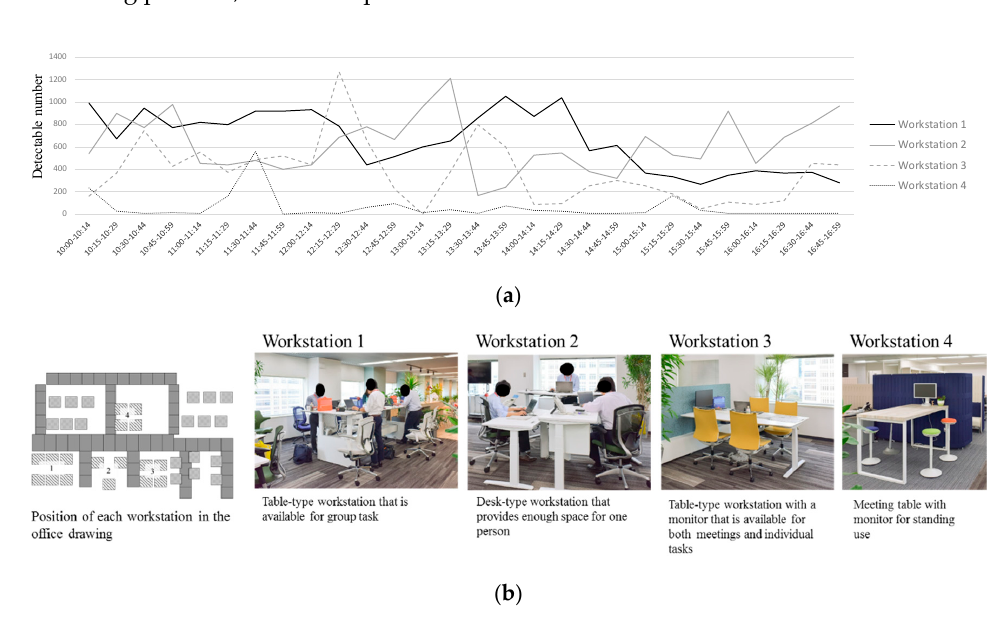
Figure 3. Detectable number of persons in each shared workstation at post-renovation. ( a ) detectable number in each time slot; ( b ) location and characteristics of each shared workstation.